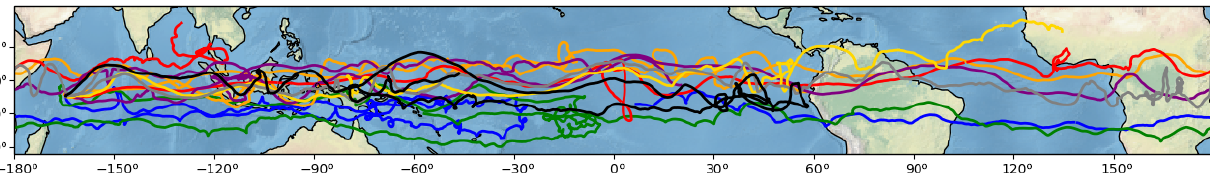
Figure 1. Trajectories of the eight SPBs.